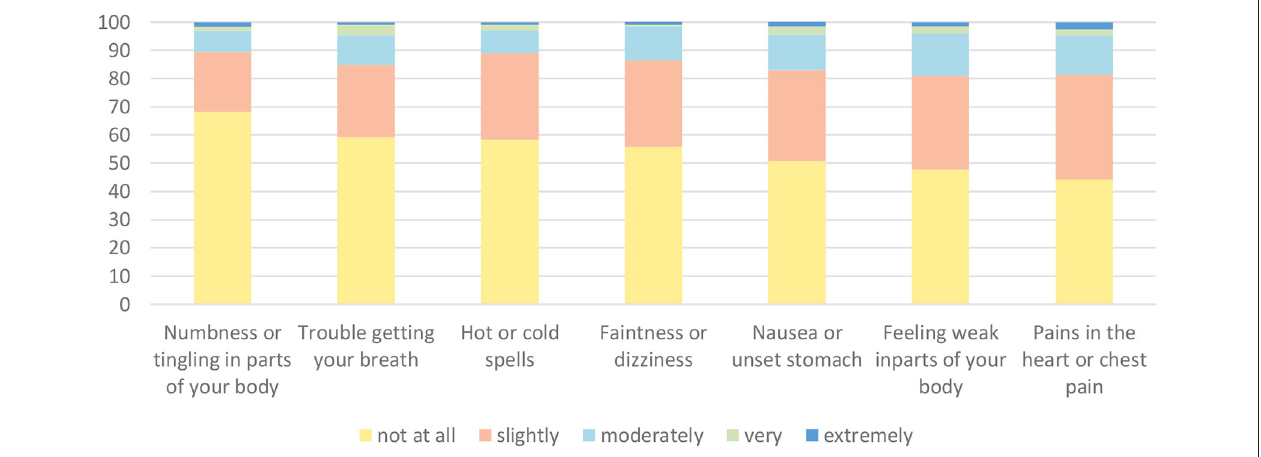
FIGURE 1 | The percentage of specific somatization symptoms.